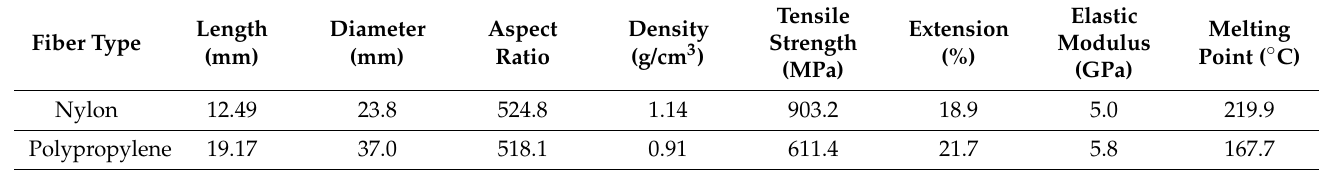
Table 4. Mechanical properties of